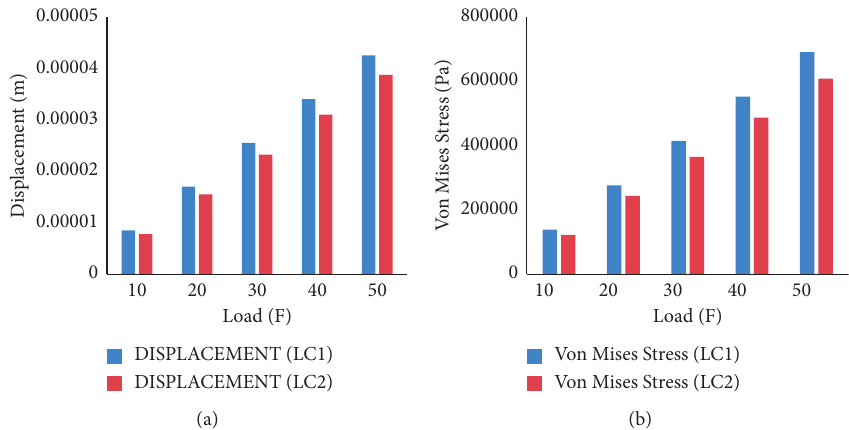
Figure 10: (a) Plot of displacement against load for LC1 and LC2 and (b) plot of Von Mises stress against load for LC1 and